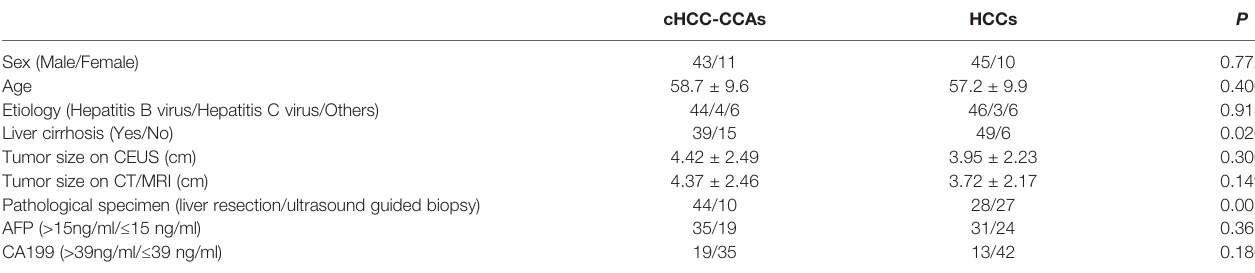
TABLE 1 | Clinical characteristics of patients in the cHCC-CCAs and HCCs groups.